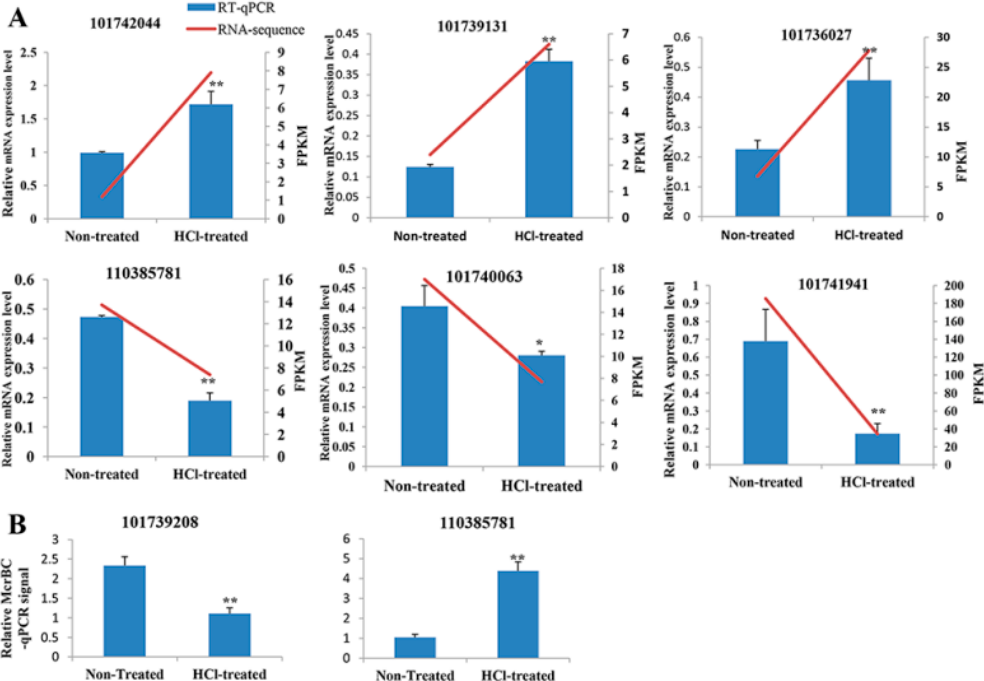
Figure 4. Validation of RNA-seq and whole-genome sequencing coupled with bisulfite DNA treatment (WGBS). Three genes that were significantly upregulated (101742044, 101739131 and 101739208) and three genes that were significantly downregulated (110385781, 101740063 and 101741941) from RNA-seq analyses were selected for mRNA quantification using RT-qPCR ( A ). DNA methylation levels of the hypermethylated gene, (101739208) and the hypomethylated gene, (110385781) from our WGBS were analyzed using methylation-sensitive McrBC-qPCR ( B ). Methylated DNA was digested by McrBC; thus, higher qPCR signals indicate lower methylation levels, and lower qPCR signals indicate higher methylation levels. Significant di ff erences are indicated by ** p < 0.01 and * p < 0.05.